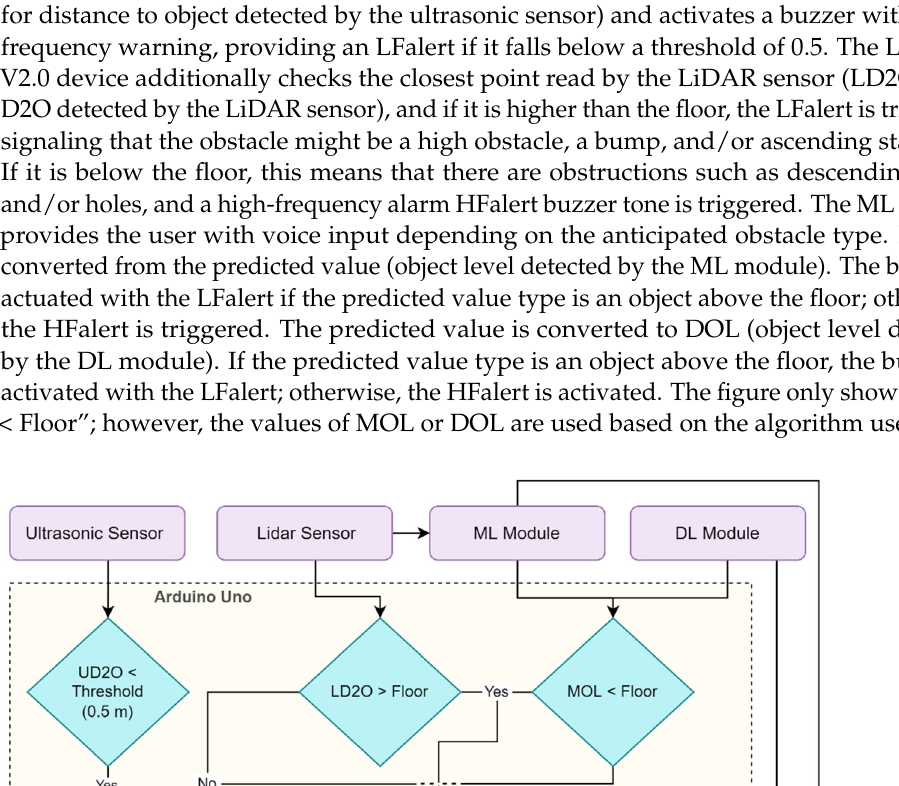
Figure 9. Sensor Coverage.